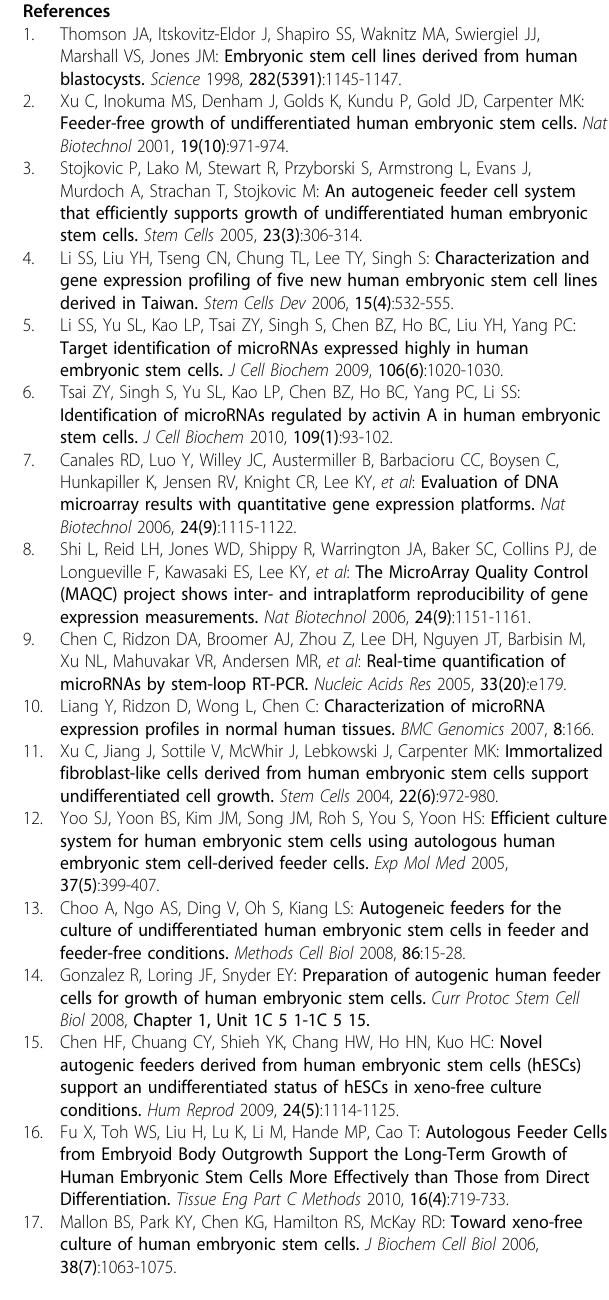
Additional file 2: Table S1A . 102 genes abundantly differentially expressed in T3/HDF cells. Additional file 3: Table S1B . 84 genes abundantly differentially expressed in T3/CMHDF cells. Additional file 4: Fig. S2 . Hierachical clustering (left) and principle component analysis (right) of all microarray data. Additional file 5: Table S2 . The expression levels and fold-changes of 21 “ stemness ” genes and 9 differentiation markers in T3/HDF, T3/CMHDF, T3/MEF and T3/CMMEF cells.